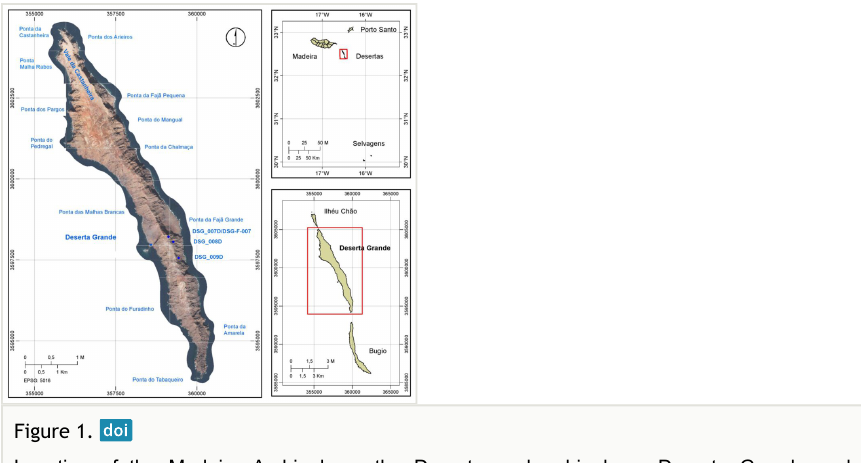
Location of the Madeira Archipelago, the Desertas subarchipelago, Deserta Grande and sampled freshwater